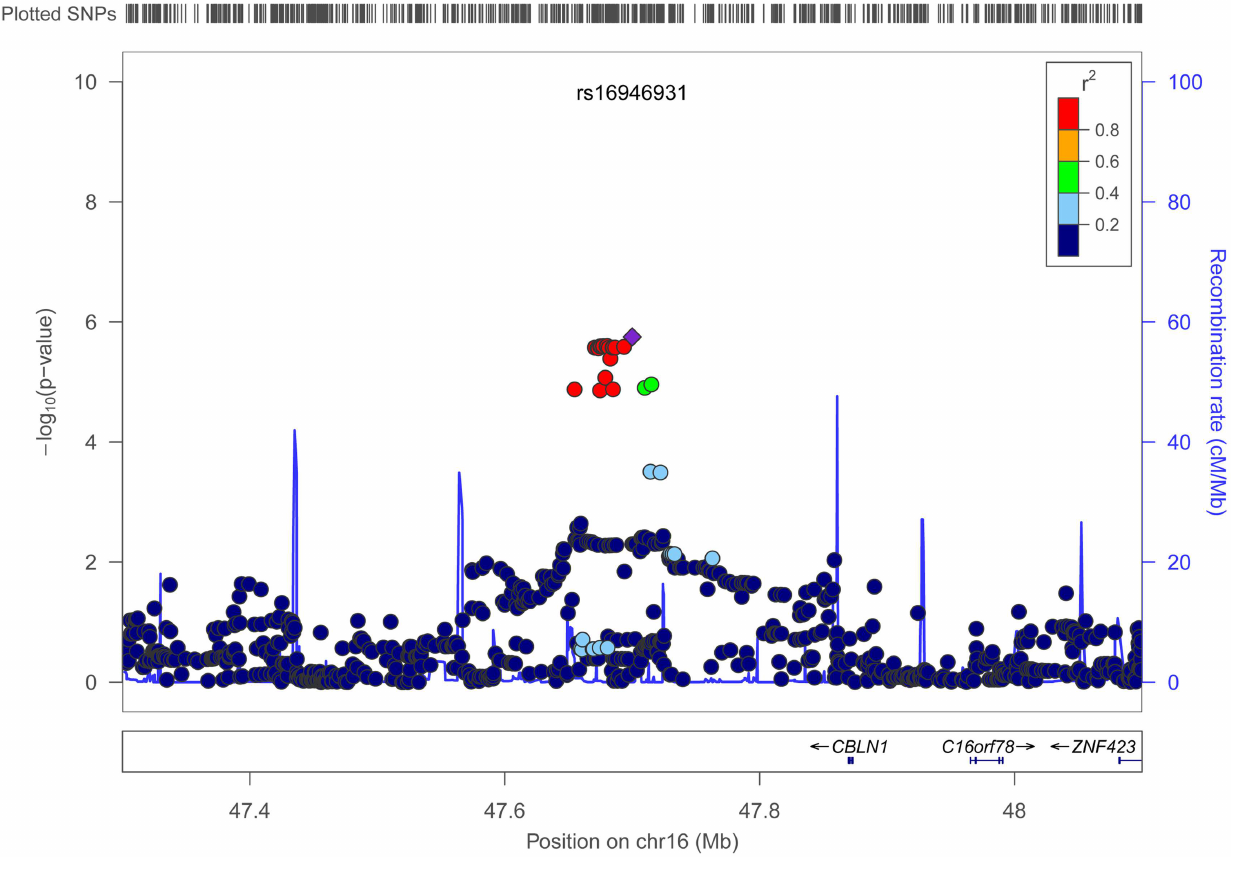
diamond; the correlations ( r 2 ) of each of the surrounding SNPs to the top SNP are shown in the indicated colors. Recombination rate is shown in pale blue.